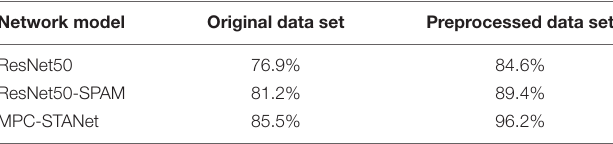
TABLE 6 | Performance evaluations of each disease